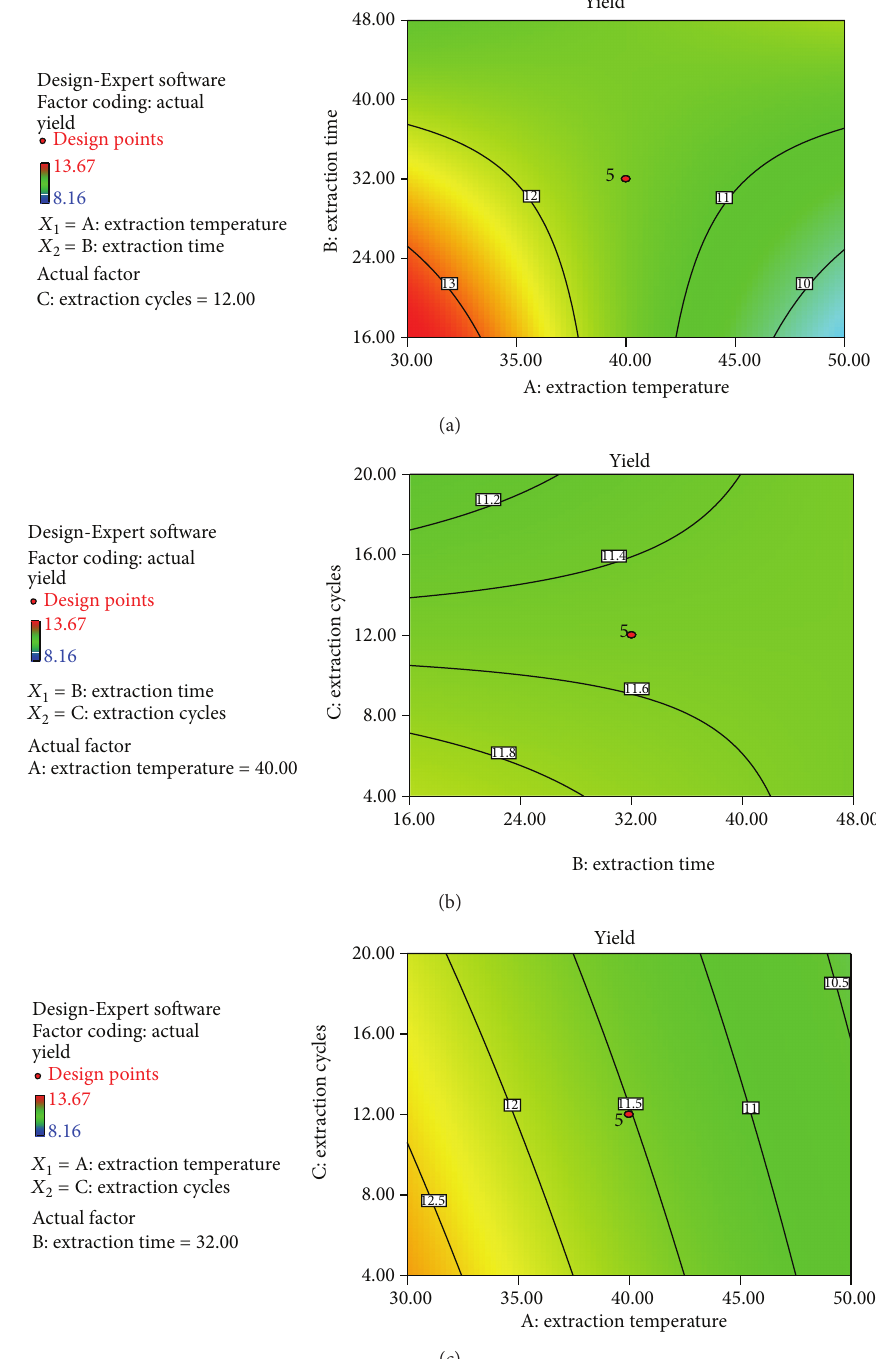
the yield of Tinospora cordifolia were significant, though the linear, quadratic, and cubic terms were not (see Table 3). An overall model was